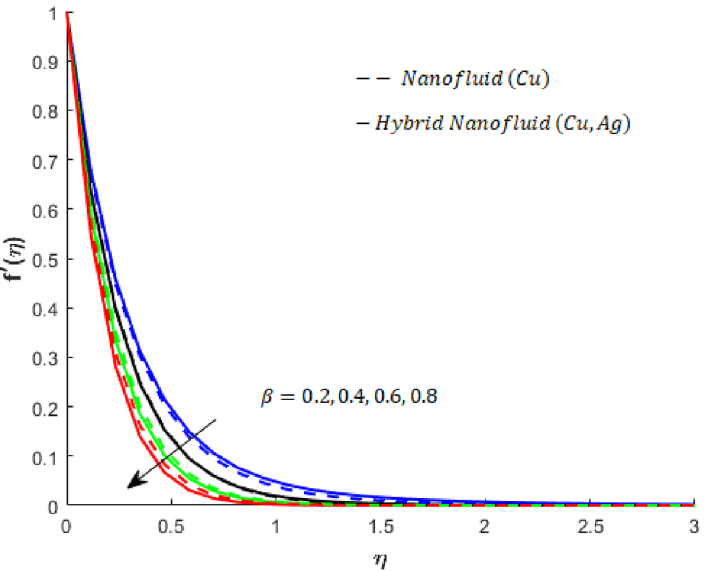
Figure 2. Influence of β on f ′ when ( Gr ) t = 0.5, Pr = 4, Sc = 5, K ∗ = 0.1, Ec = 0.001, ( Gr ) c = 0.3, M = 0.5, β ∗ = 0.2, Sr = 0.1 and 0.2 Du =